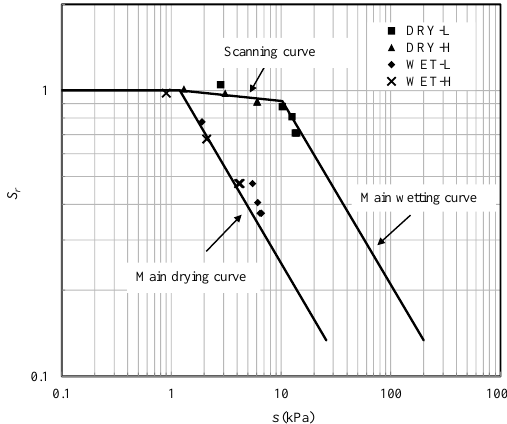
Figure 7. Illustration of the hydraulic states locations on the SWCC.